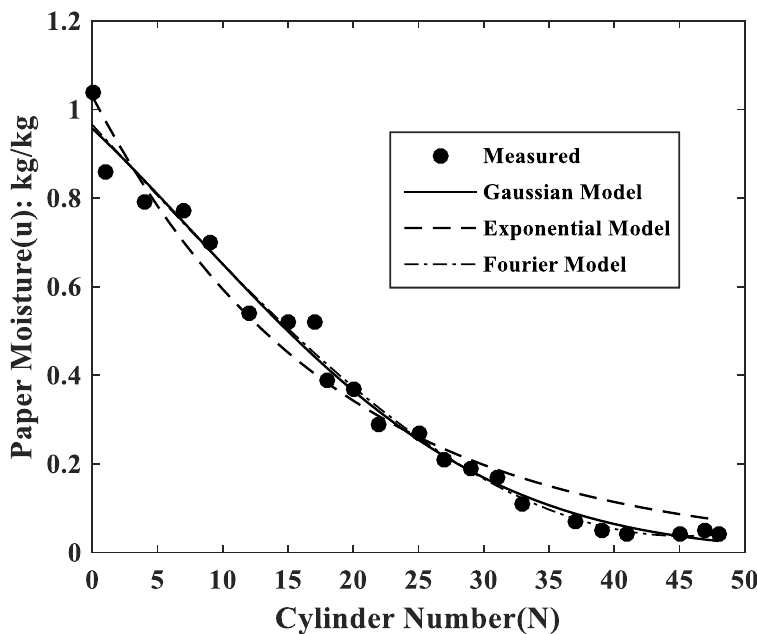
Figure 6. Measurement and analysis of drying curve in industrial production. Table 3. Fitting results of drying curve data in industrial production.